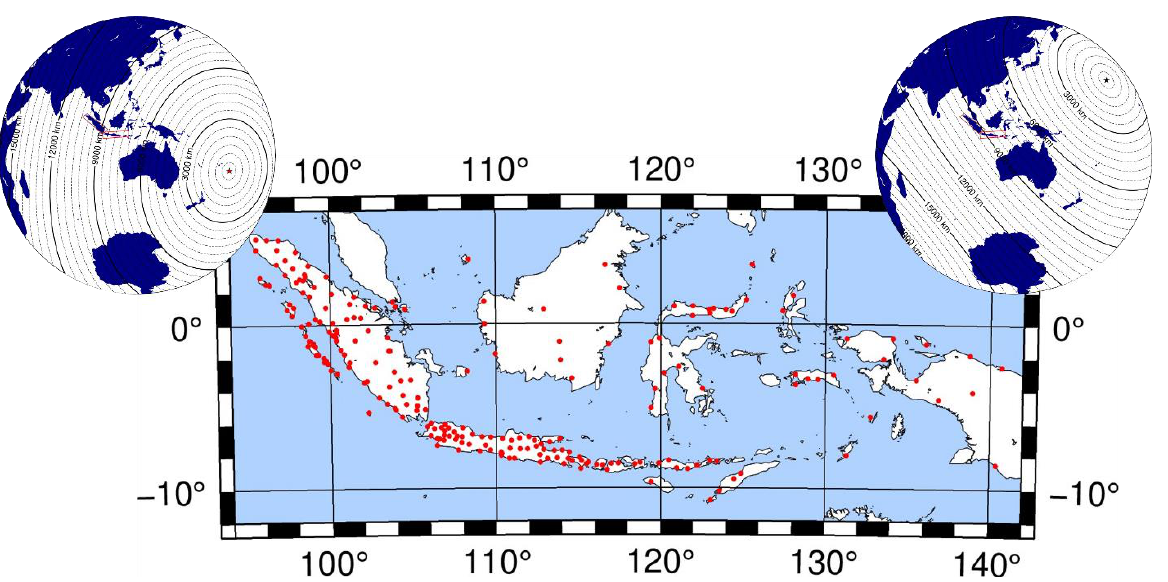
Figure 1. Indonesian GNSS networks run by BIG and EOS/BRIN of Sumatran GPS Array in Indonesia and around Sumatra Islands (red circle). The globes indicate contour of distance from HTHH (red star, in upper left area of globe) and from its conjugated point (black star in the upper right globe). Table 1. Expected passage time ranges of LW (0.3 km/s) from